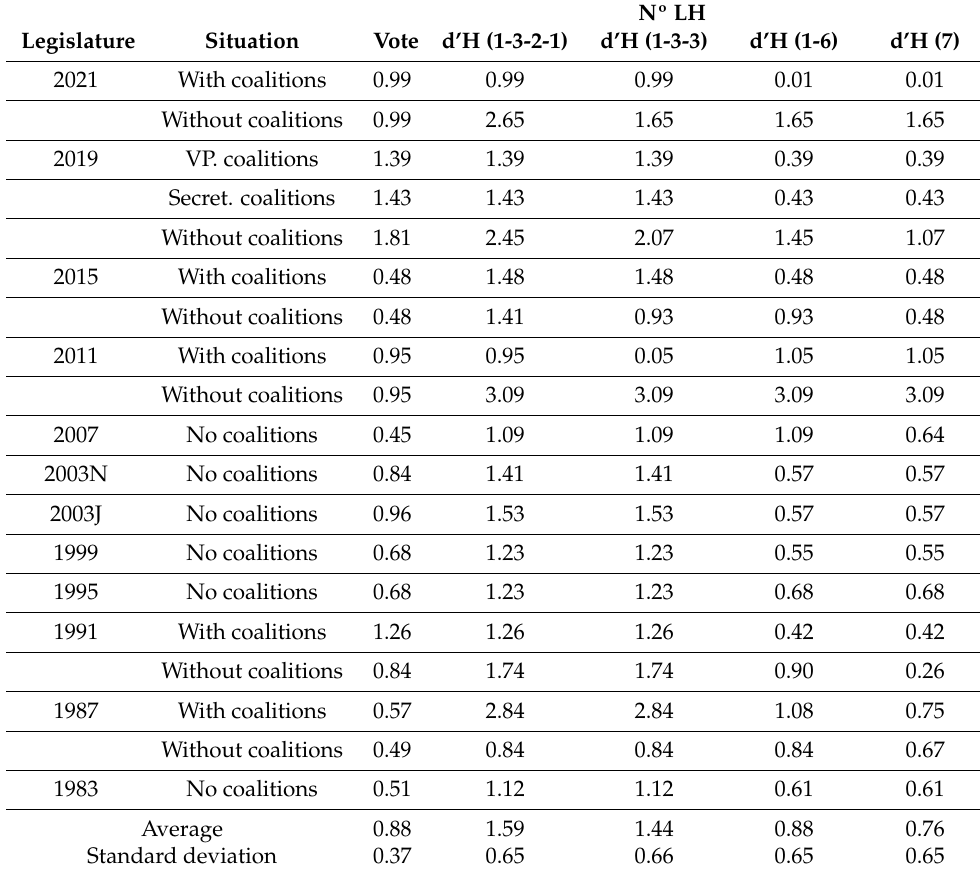
Table 16. Number of posts non-proportionally allocated as a function of d’Hondt